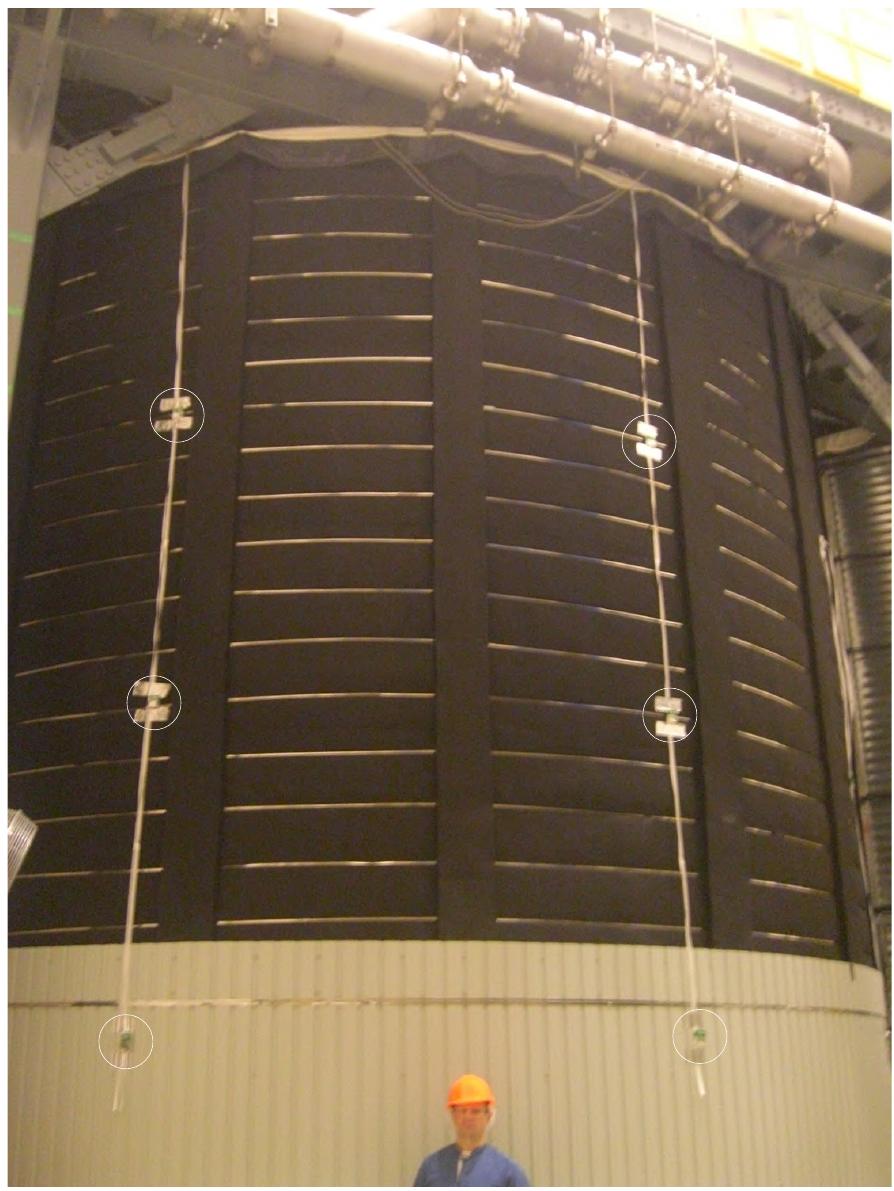
Figure 4. Integrating passive TLD detectors deployed at DEAP-3600 water shielding. Six of the badges, circled in the picture, were distributed around the water shield. Each badge contained two TLD-100 chips (see Figure 3) practically at the same spot. TLDs that were hosted inside badge ID 29 (see Table 1) were placed at the top of the DEAP-3600 water shielding. The MiniCLEAN water tank is also partially